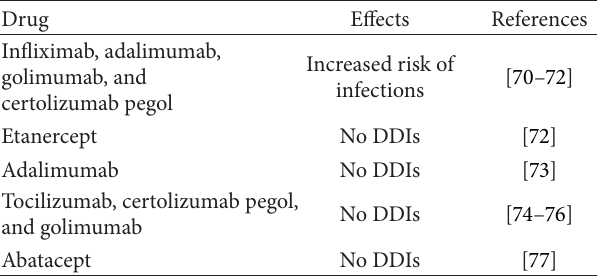
Table 5: DDIs between MTX’s and biological drugs.